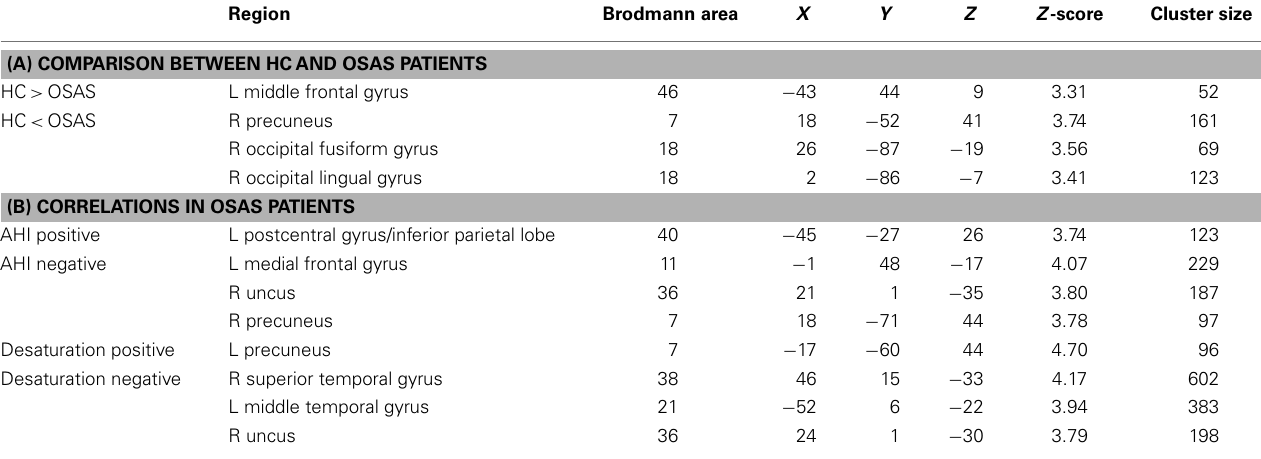
Table 2 | Gray matter volume (GMV) analysis results: (A) brain regions showing significant differences in GMV between healthy controls (HC) and obstructive sleep apnea syndrome (OSAS) patients; (B) brain regions showing significant correlation with the apnea–hypopnea index (AHI) or with nocturnal hypoxemia duration in OSAS patients (MNI coord.; 20 vox., uncorrected p < 0.001).